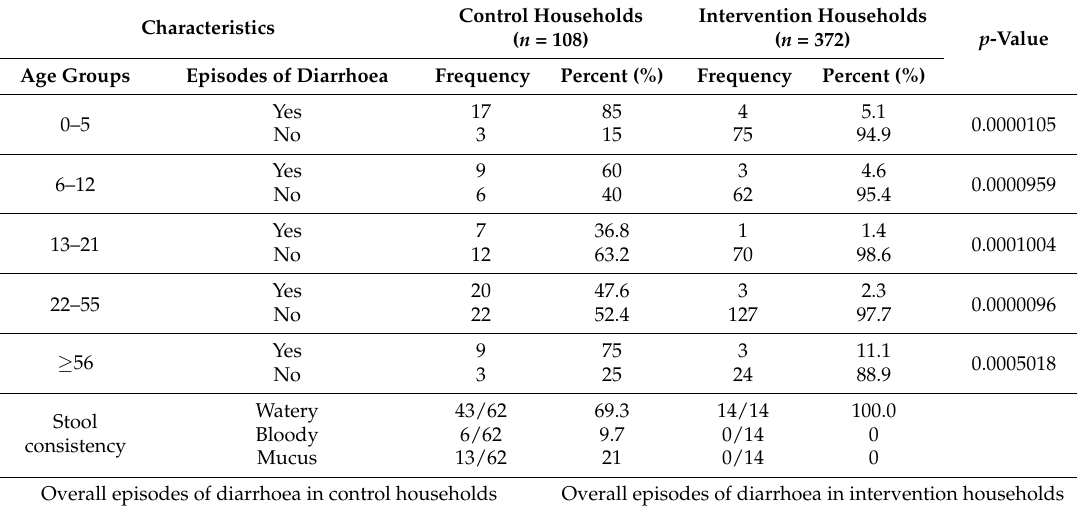
Episodes of diarrhoea per age group and stool consistency subsequent to HWTS implementation in Makwane